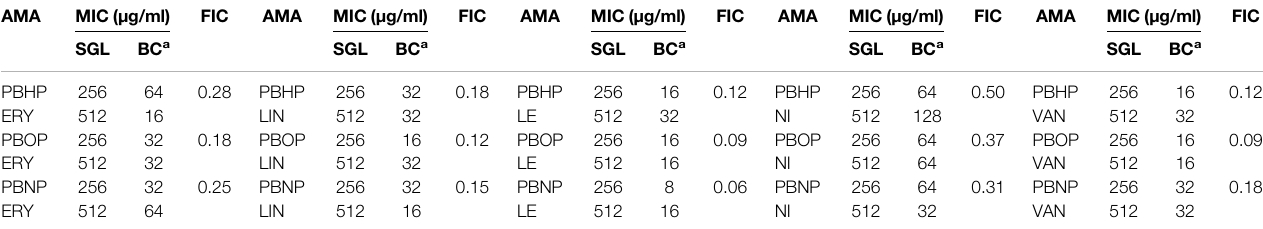
TABLE 2 | FICs of three polymyxin B derivatives combined with fi ve antibiotics against K. pneumonia . AMA MIC ( μ g/ml)